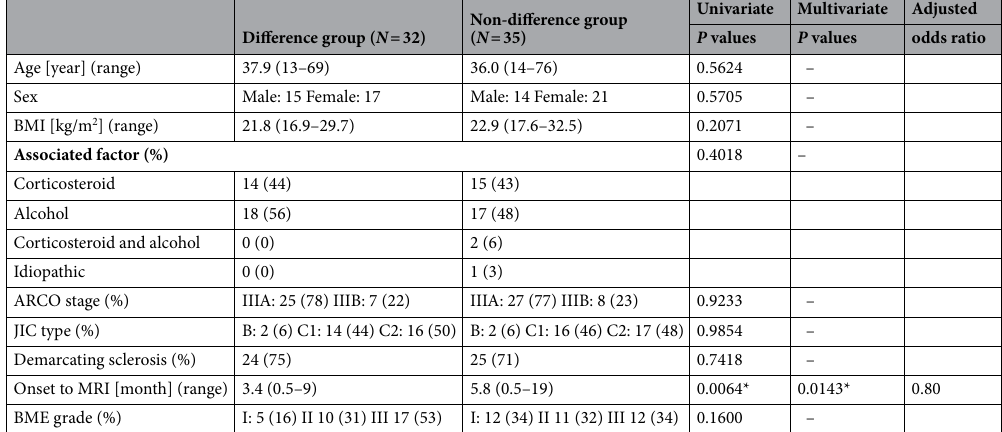
Table 2. Univariate and multivariate analyses for oblique-axial plane in the difference in the boundary of necrotic lesion group and the non-difference in the boundary of necrotic lesion group, comparing unenhanced and contrast-enhanced T1-weighted MR images. * P < 0.05 indicates